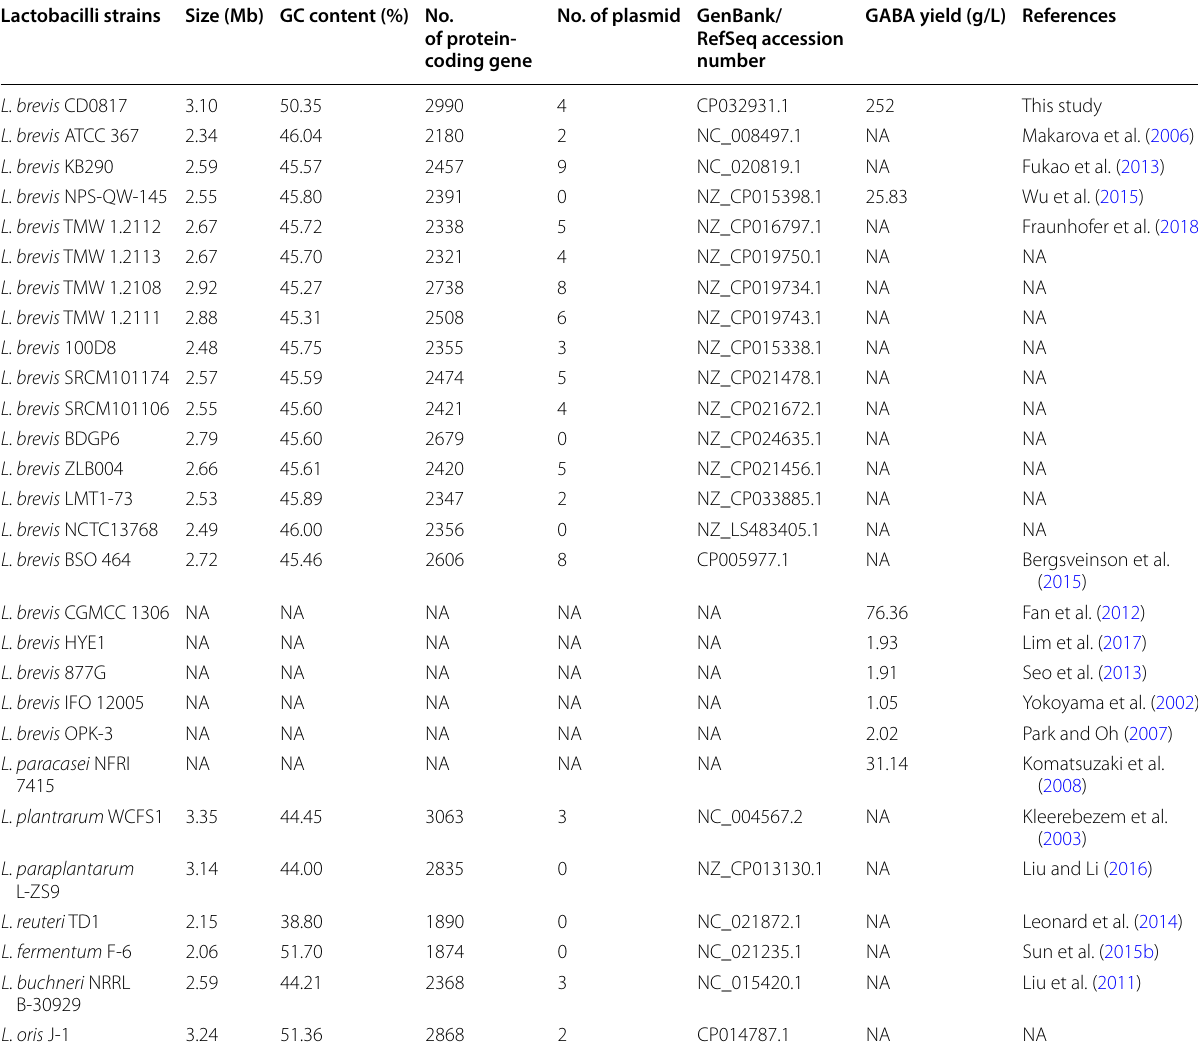
NA: not available; the CD0817 and 15 completely sequenced Lactobacillus brevis strains were selected for comparative genomics analysis; all lactobacilli strains listed in the table were selected for GAD analysis